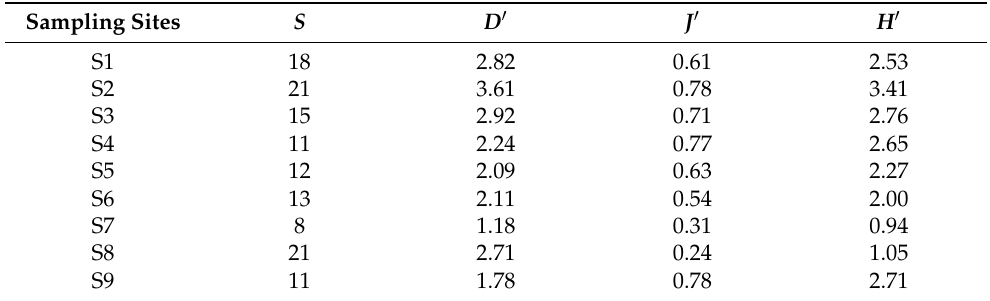
Table 3. Biodiversity indices of phytoplankton communities in the waters around Macau.